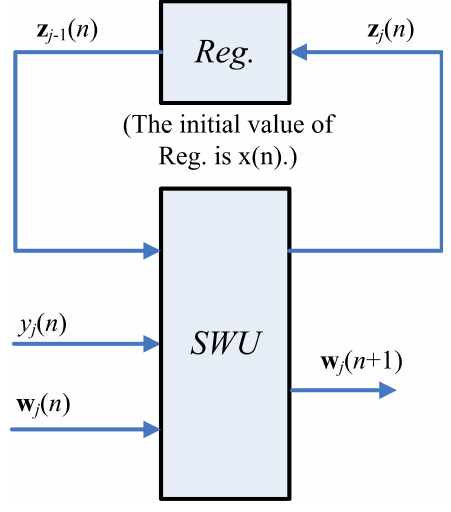
Figure 3. The hardware implementation of Equations (6) and